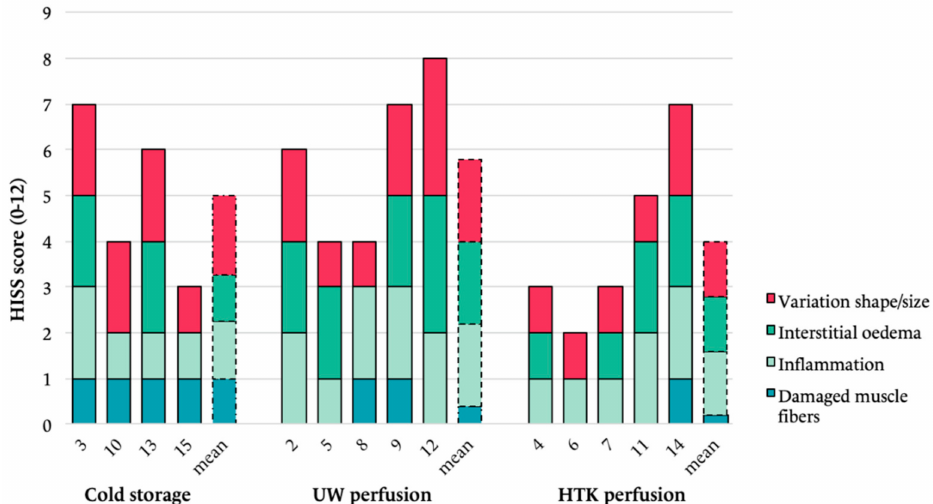
Figure 5. Boxplot showing an overview of histological changes at the study endpoint indicating ischemia-reperfusion injury per flap and group. Cell count per 10 high-power fields at 20× magnification. Scoring for inflammation and interstitial oedema: 0 = no, 1 = minimal, 2 = intermediate, 3 = diffuse.